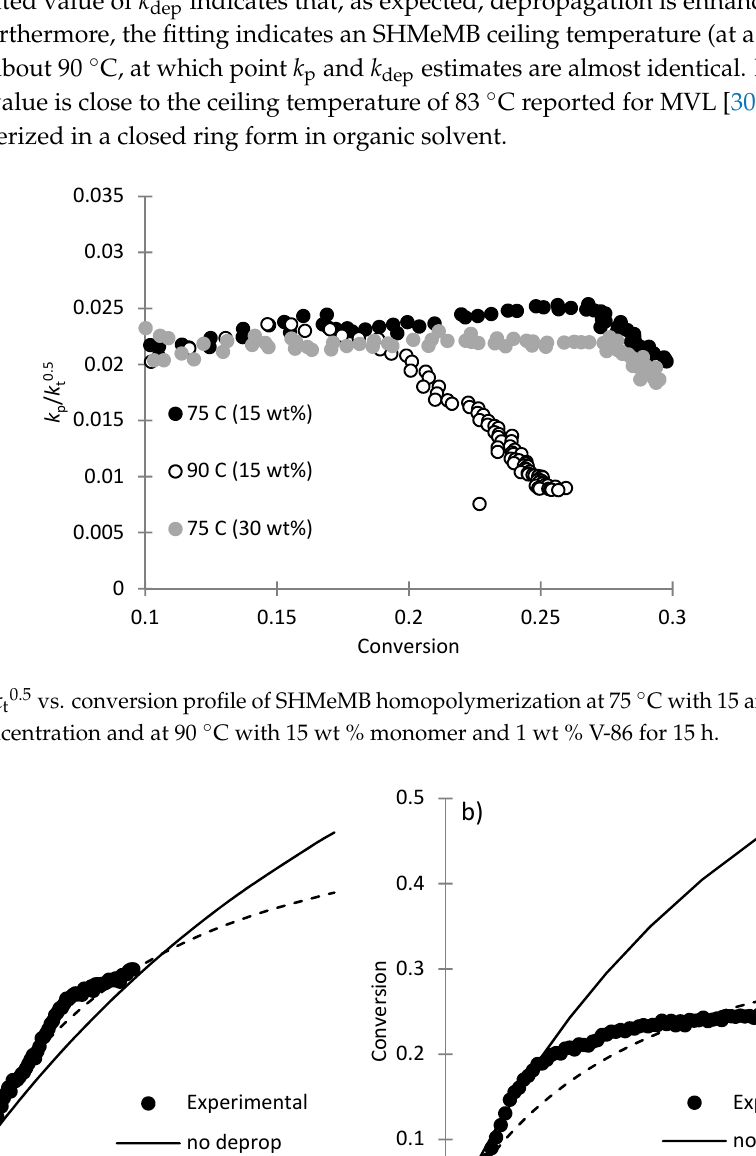
Figure 9. Monomer conversion profiles for the homopolymerization of SHMeMB at 75 °C with 1 wt % V-86 and 30 wt % monomer. The solid line represents the estimated conversion profile using parameter estimation.